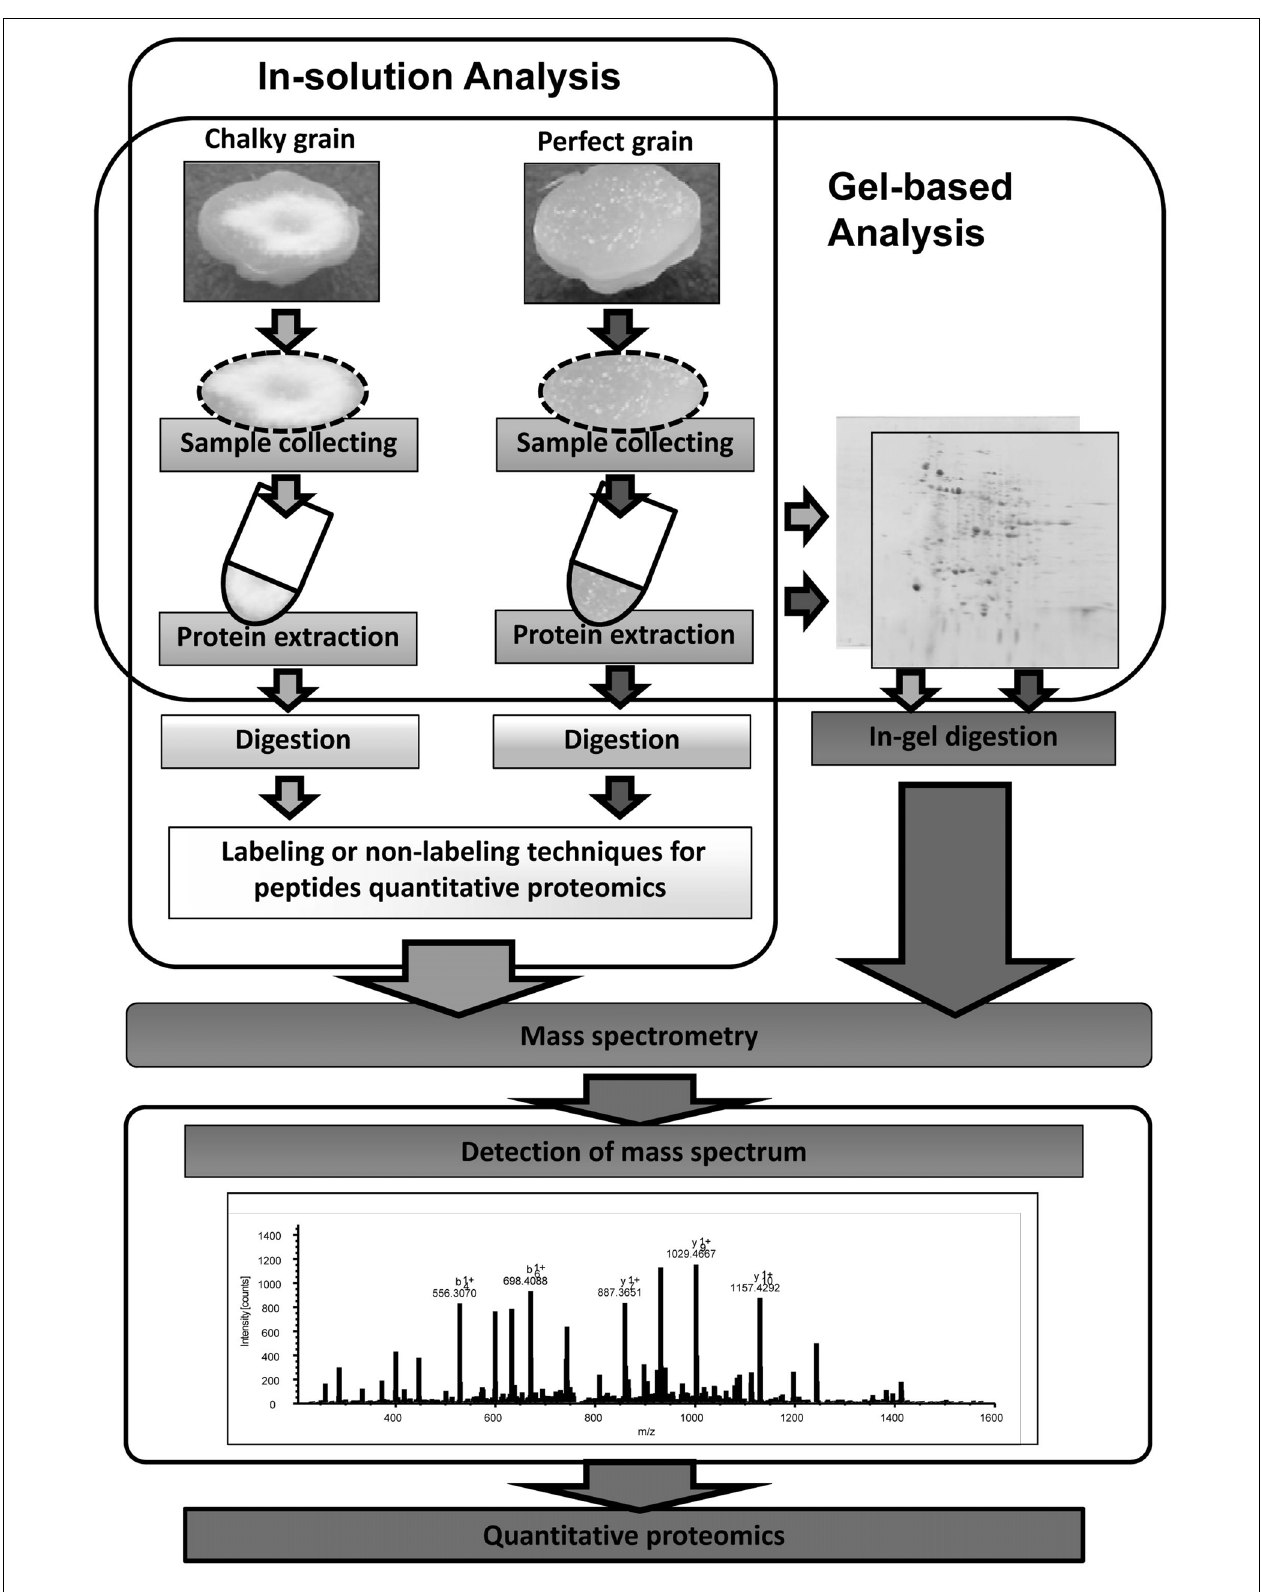
FIGURE 2 | Local proteomic strategies for understanding the chalking mechanisms of rice grains.